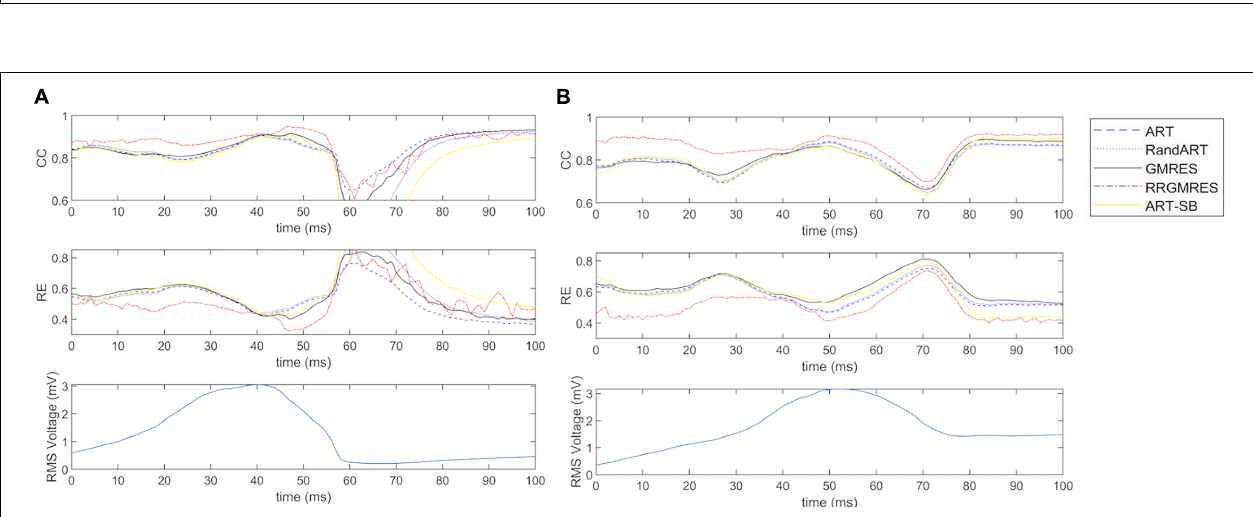
Frontiers in Physiology |